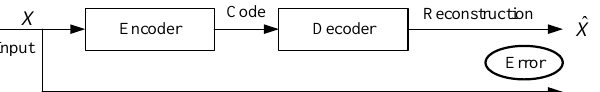
Figure 2. Conceptual diagram of the auto-encoder. Figure 3. Detailed description of auto-encode (AE).